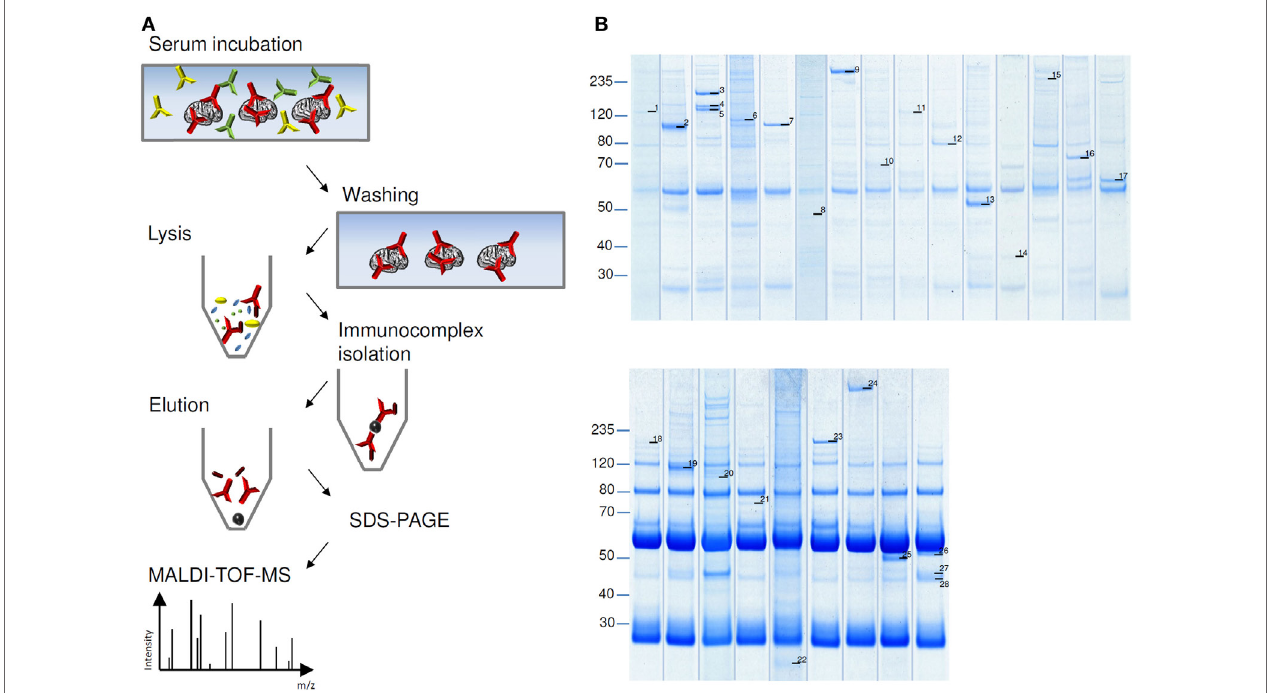
FigUre 3 | Immunoprecipitation of autoantigens. (a) Schema of histo-immunoprecipitation (HIP) with cerebellum cryosections immobilized on glass slides. Slides were incubated with patient’s serum followed by washing and removal of unbound antibodies. Cells were lysed and soluble immunocomplexes were isolated by protein-G-coated magnetic beads. Sodium dodecyl sulfate (SDS)-eluted proteins were separated by SDS-polyacrylamide gel electrophoresis and visualized by staining with colloidal coomassie blue. Antigen bands were prepared and analyzed with matrix-assisted laser desorption/ionization–time of flight mass spectrometry (MALDI–TOF MS). (B) Examples of HIP (upper panel) and tissue-immunoprecipitation (lower panel). Labeled protein bands were analyzed in MALDI–TOF MS. Results are listed in Table 1